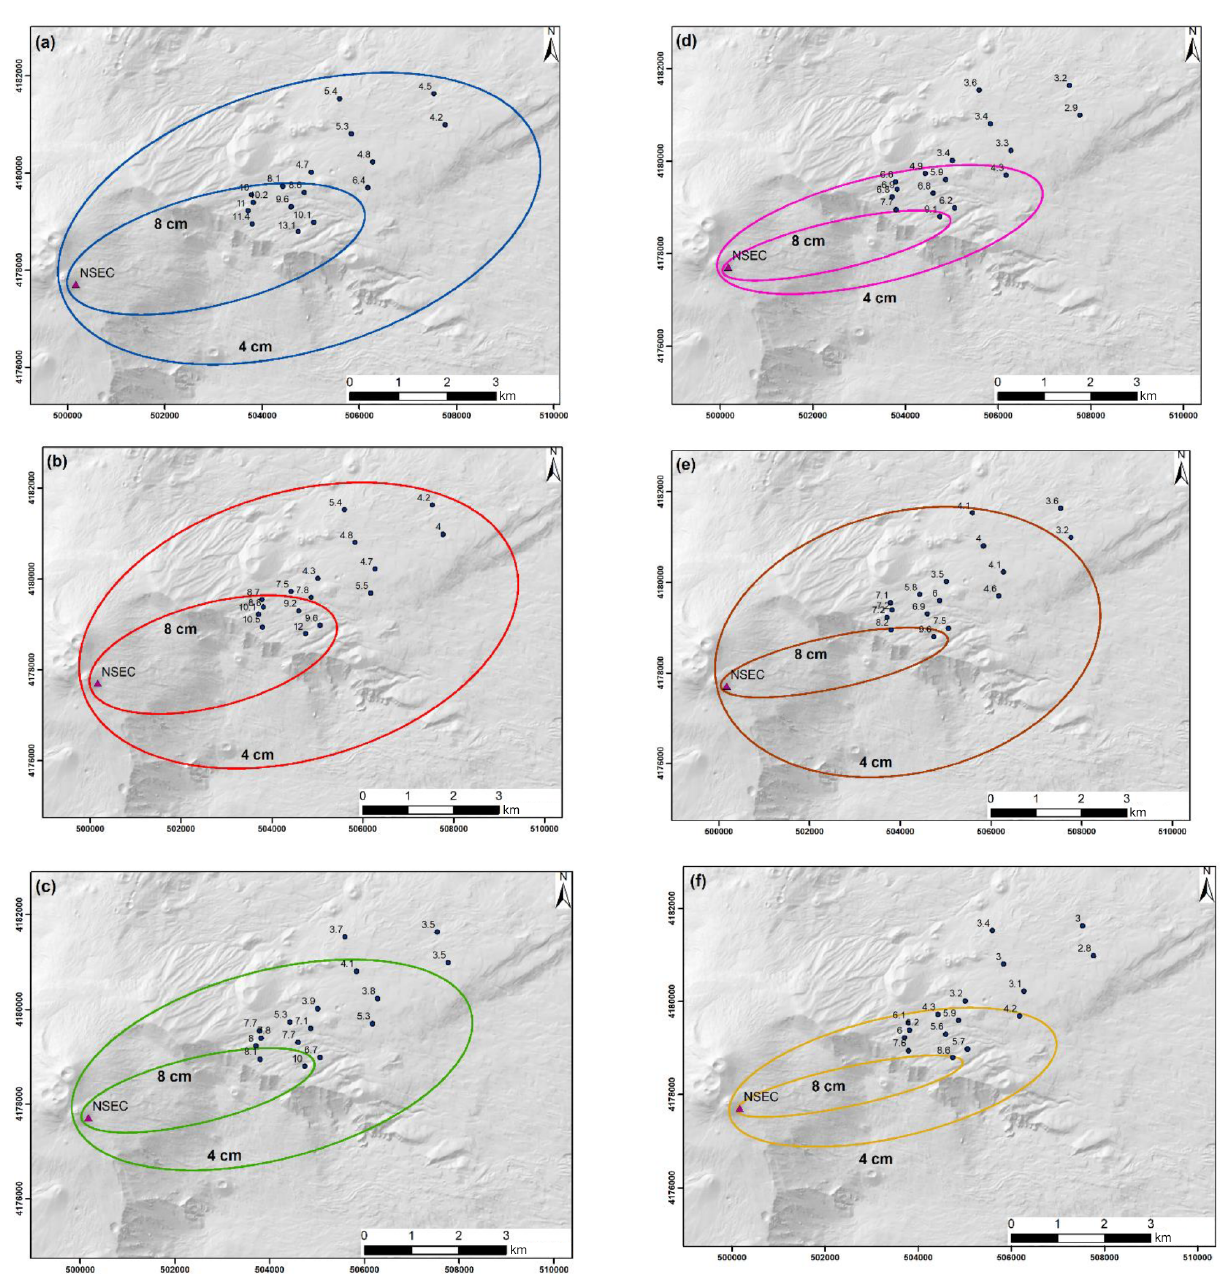
Figure A1. Isopleth maps showing the contours of 4 and 8cm clasts using different averaging strategies of field data. Note that values indicate average (a, b, c) and median (d, e, f) . (a) Average of the five largest clasts, combining all three sampling areas at each location. (b) The largest value of the average of the five largest clasts out of the three sampling areas of each location. (c) The smallest value of the average of the five largest clasts out of the three sampling areas of each location. (d) The median value of the combination of all three sampling areas at each location. (e) The largest value of the median of the combination of the three sampling areas of each location. (f) The smallest value of the median of the combination of the three sampling areas of each